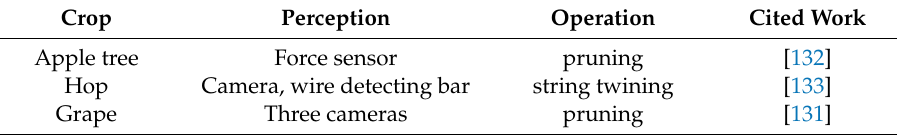
Table 8. Plant management agrirobotic systems for various